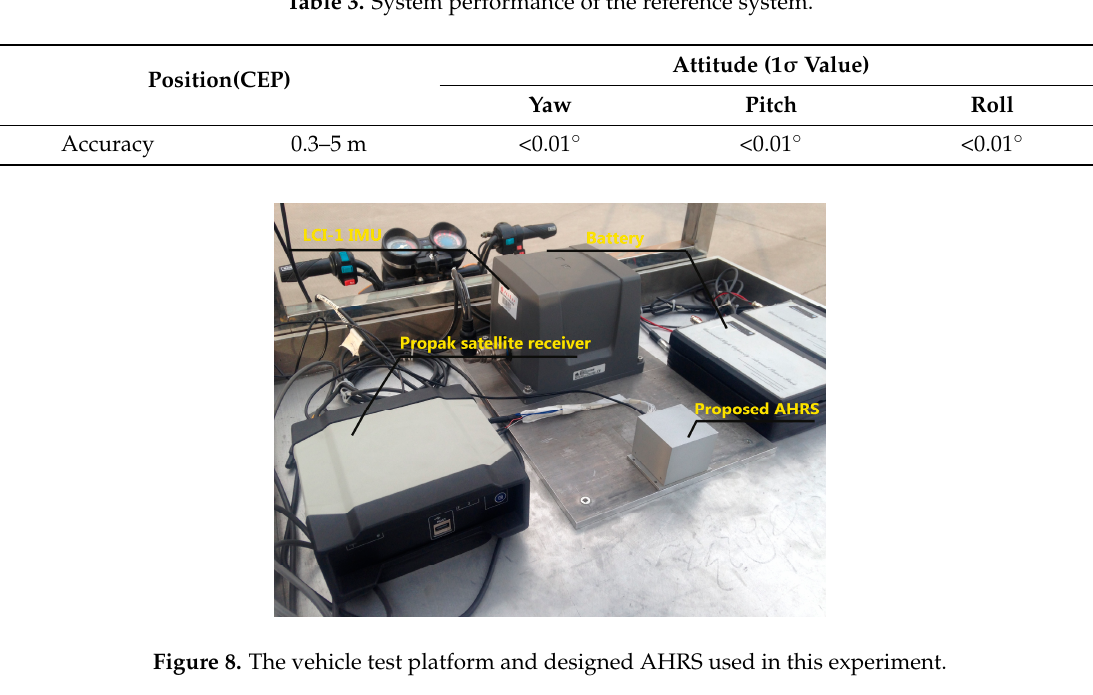
Table 3. System performance of the reference system.